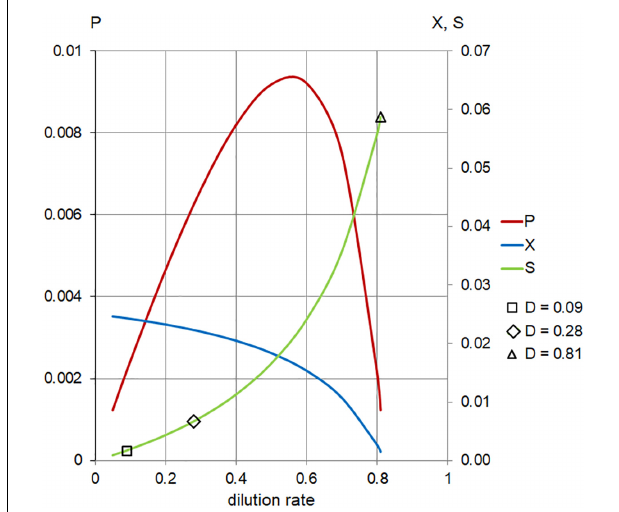
FIGURE 6 | Calculated steady-state values for the model set in Table 1 , Case 2. Concentration of limiting nutrient ( S , green), suspended bacterial biomass ( X, blue), and biomass production ( P , red); left axis, P (arbitrary units/hour); right axis, X , S (arbitrary units); and horizontal axis, dilution rate ( D ; h − 1 ). Markers indicate values of S for dilution rates ( D; h − 1 ) used in the chemostat experiments.